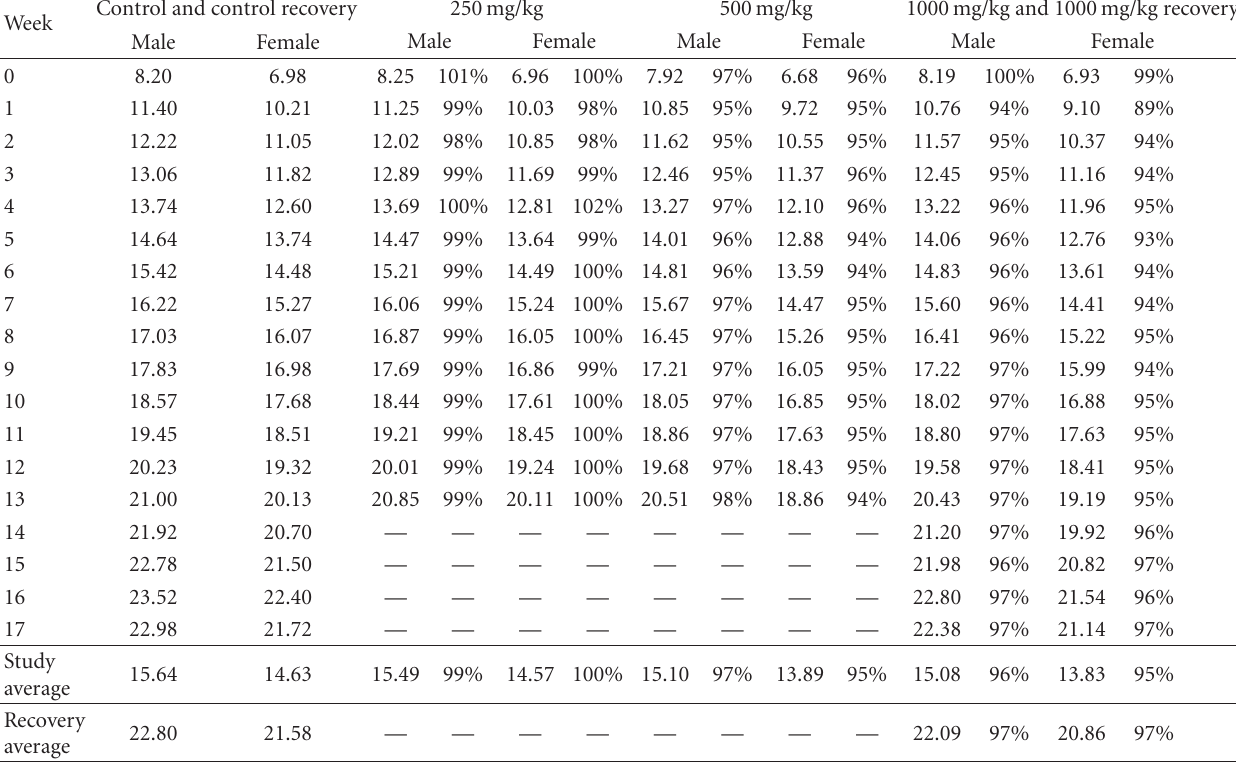
Table 1: Group mean feed consumption of male and female rats given Zigbir (cid:2) daily by gavage for 90 days. Control and control recovery Week